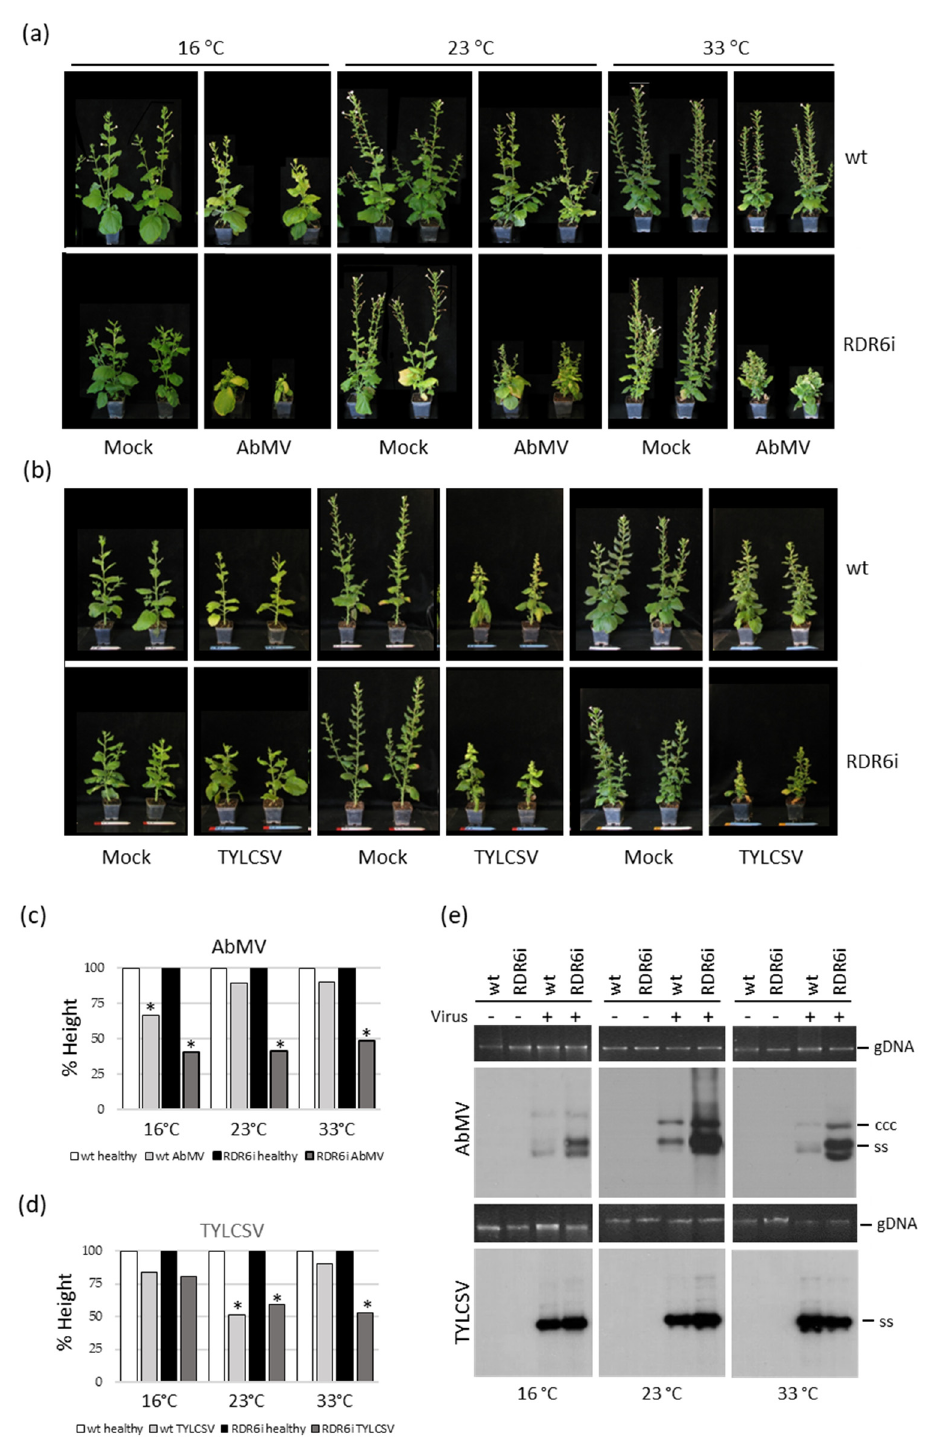
Figure 2. Impact of plant cultivation temperature and RDR6 depletion genotype (RDR6i) on AbMV and TYLCSV infection. ( a , b ) Symptom expression on wild-type (wt) and RDR6i Nicotiana benthamiana plants infected by either ( a ) AbMV or ( b ) TYLCSV, grown at constant temperatures of 16, 23, and 33 °C. Mock-inoculated plants served as controls. Photographs were taken at 49 dpi. Inoculation assays were repeated twice, using a total of 10 plants per genotype and infection type. ( c , d ) The height of wt and RDR6i plants mock-inoculated or infected with either ( c ) AbMV or ( d )